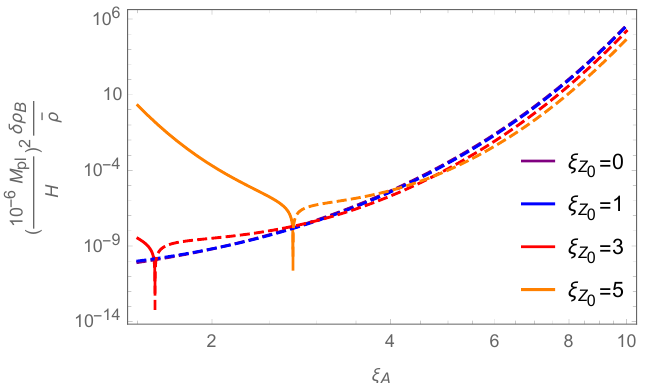
(cid:26) , as a function of (cid:24) A and for di(cid:11)erent values B